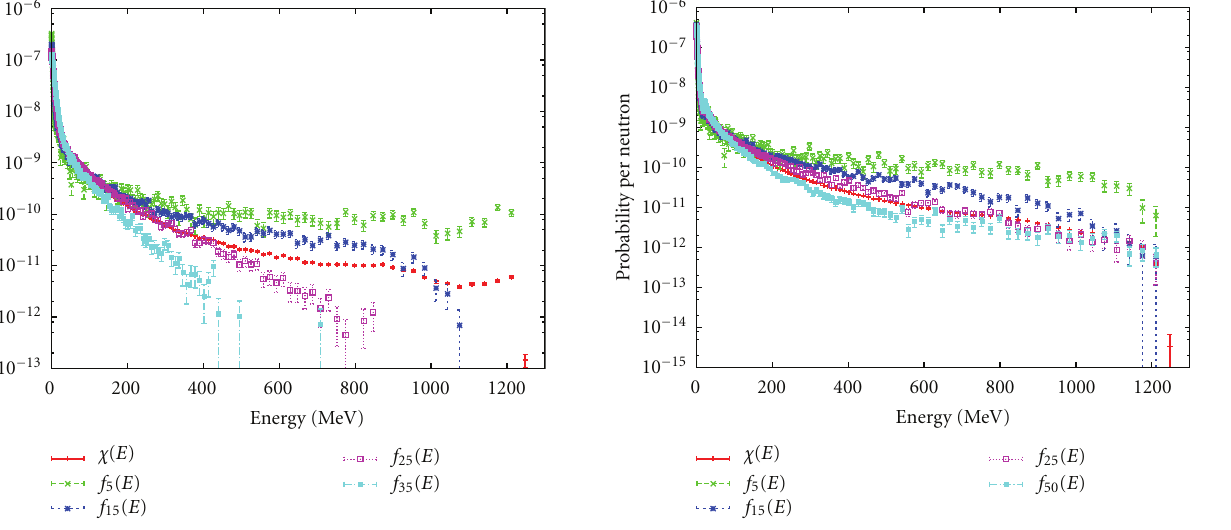
Figure 8: One-particle energy distributions f q ( E ) for di ff erent number of produced neutrons q and average spectrum χ ( E ) calculated for the 35 cm thick target.